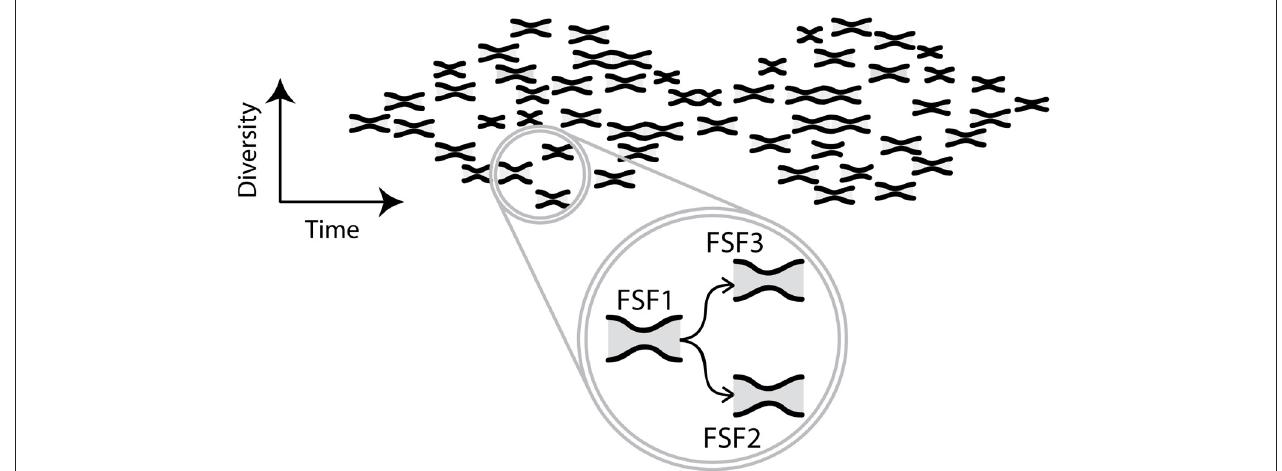
FIGURE 4 | Evolution of biphasic patterns. The cartoon illustrates a network of biphasic patterns of diversification of FSFs as the network of structures evolves in time. The horizontal axis represents time and the vertical axis represents diversity. Each small hourglass describes the evolution of a different FSF, through convergence from more to fewer variants of the FSF, with subsequent diversification of its variants. For each small hourglass, the latter phase of diversification continues to the present, though this continuation is not shown in the cartoon. The extent of convergence and divergence, and the temporal scale, may vary among small hourglasses (not shown). Since, this interplay of diversity and time defines a multidimensional landscape it is difficult to visualize. Moreover, fewer small hourglasses are shown than the thousands of actual FSFs. In the circle, three